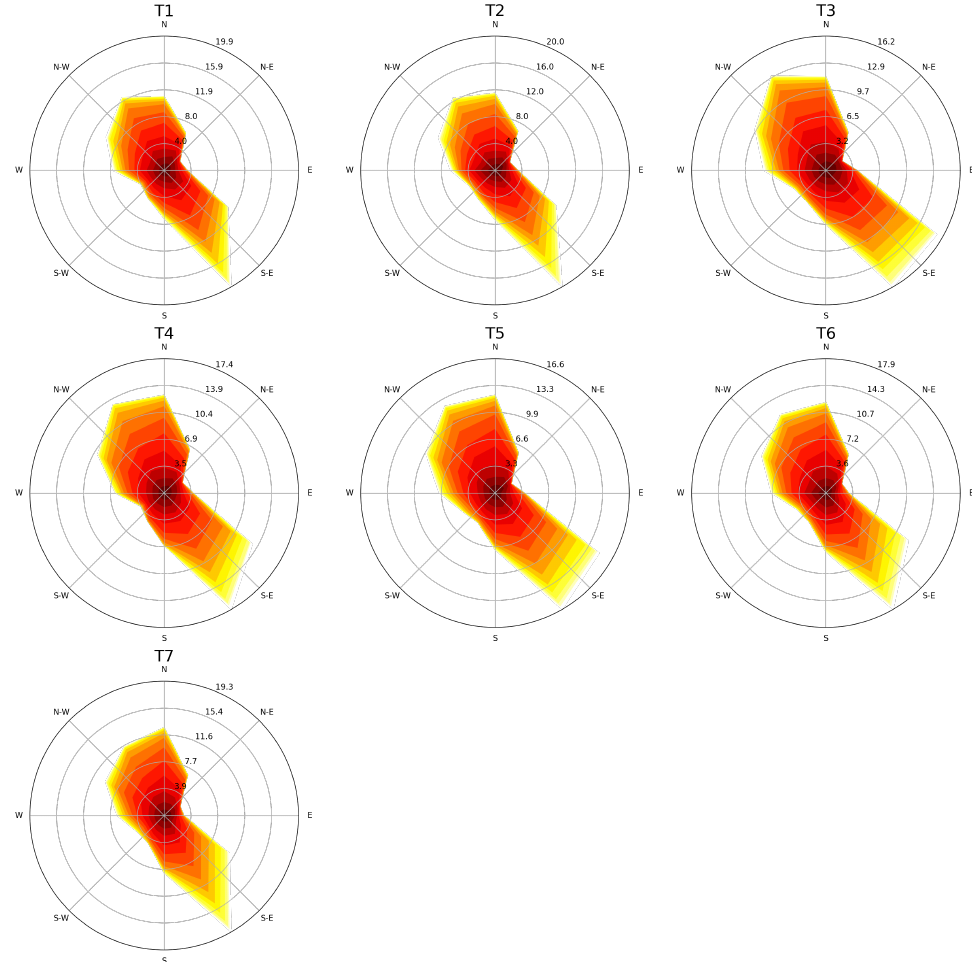
Figure 5. Wind speed directional distributions on the turbines. The wind speed and wind shear profiles for the most important wind direction sectors are reported in Figures 6 and